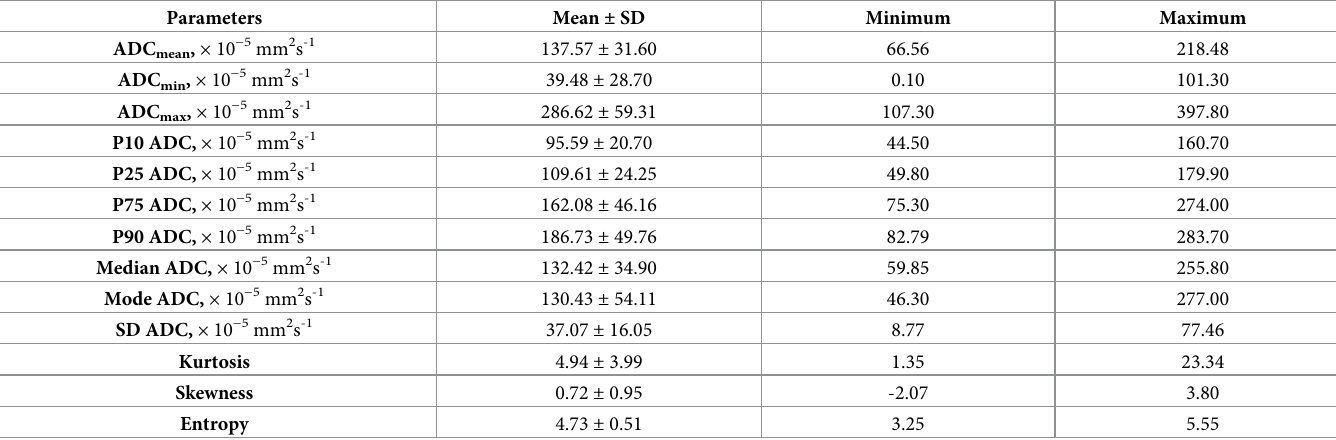
Table 1. DWI histogram profiling parameters of all investigated high-grade gliomas.